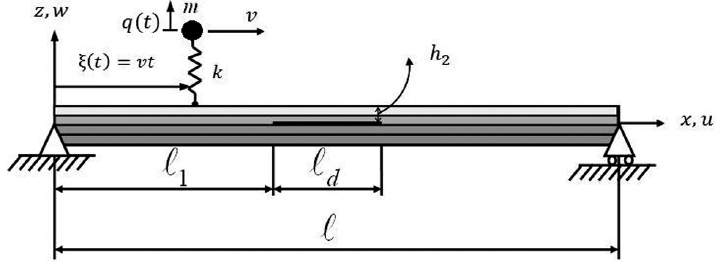
Fig. 1. Delaminated composite beam traversed by a moving oscillator.